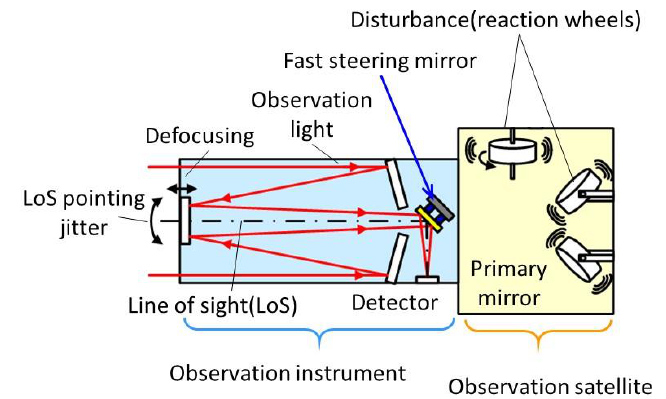
Figure 1. An observation satellite with a fast steering mirror disturbed by reaction wheels. Electronics 2020 , 9 , x FOR PEER REVIEW